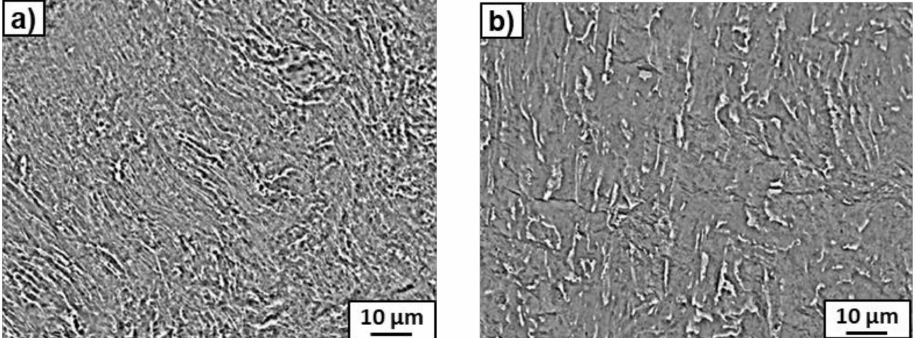
Figure 3. SEM images of the microstructure of HPT-deformed samples of the Ti–3wt.%Nb alloy pre-annealed at 450 ◦ C ( a ) and 600 ◦ C ( b ).